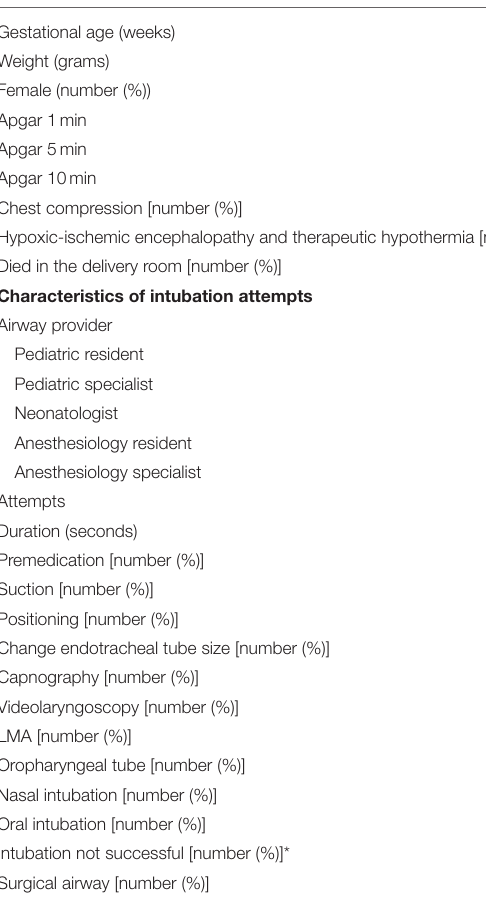
TABLE 1 | Characteristics of the infants ( n = 23) that were intubated or underwent intubation attempts and the intubation attempts ( n = 68). Characteristics of